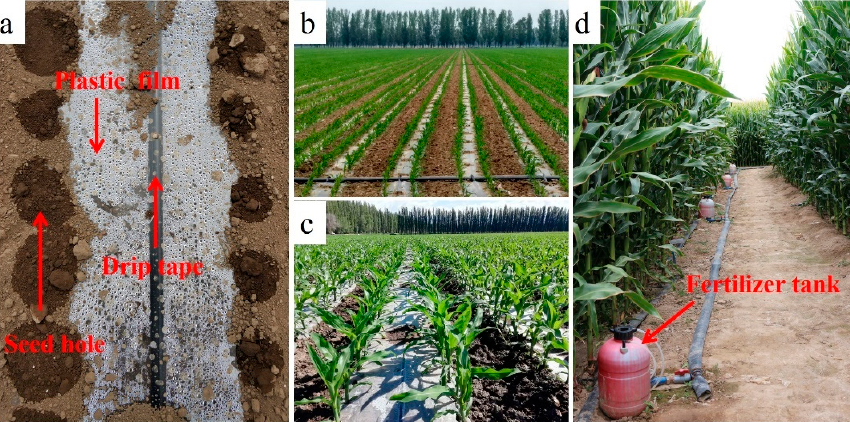
Figure 1. Field image of seeding and nitrogen dressing method. Figure ( a ) showing the relative positions of row spacing, drip tape, and plastic film. ( b – d ) are pictures of the field during the experiment.